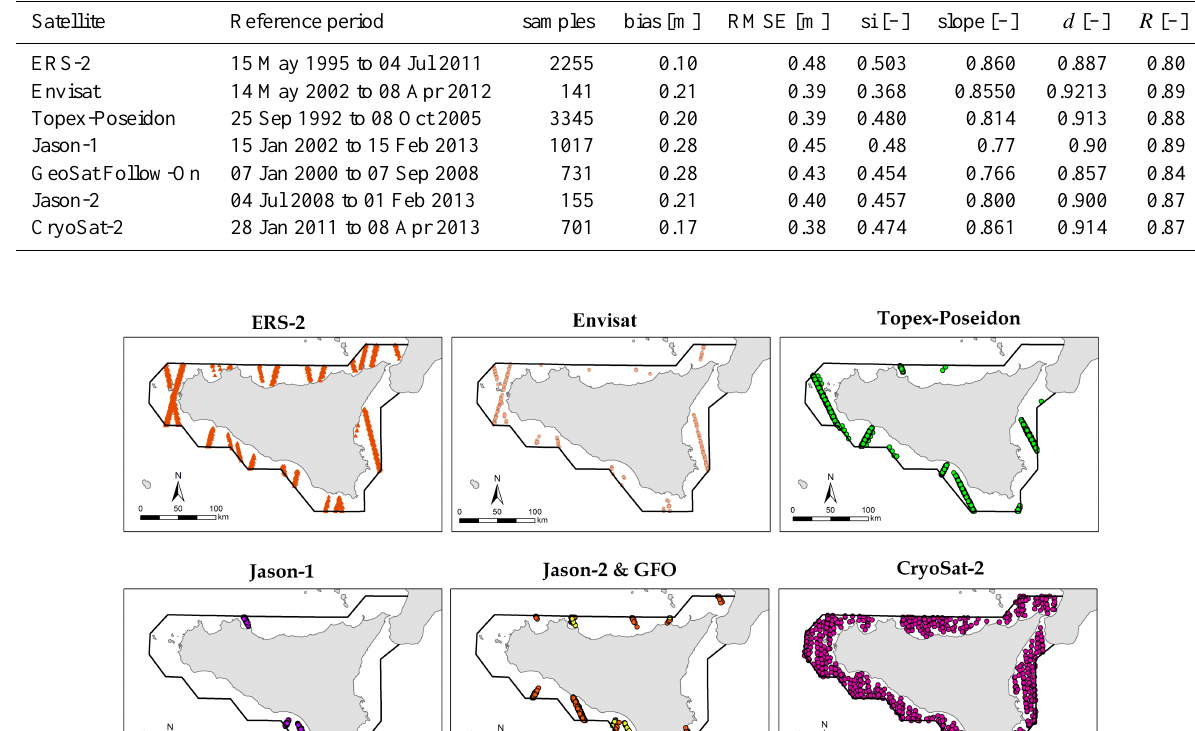
Fig. 4. The validation of the data from the SWAN model with the satellite data was performed using the parameters defined in the Appendix, and the results are shown in Table